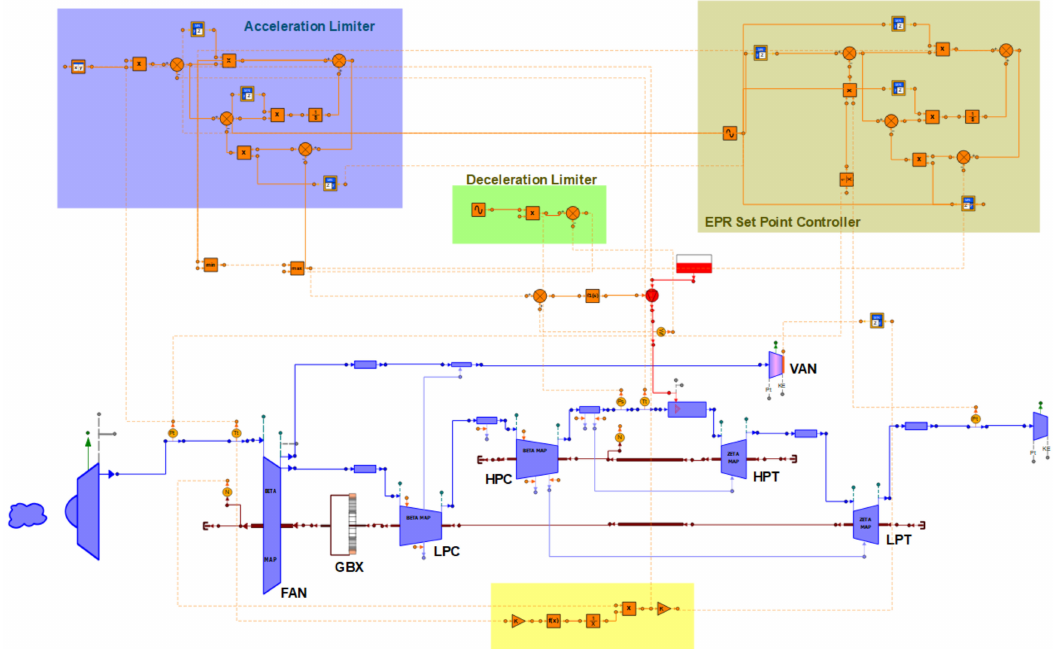
Figure 1. PROOSIS schematic diagram of the geared turbofan with the VAN and control system used in the application